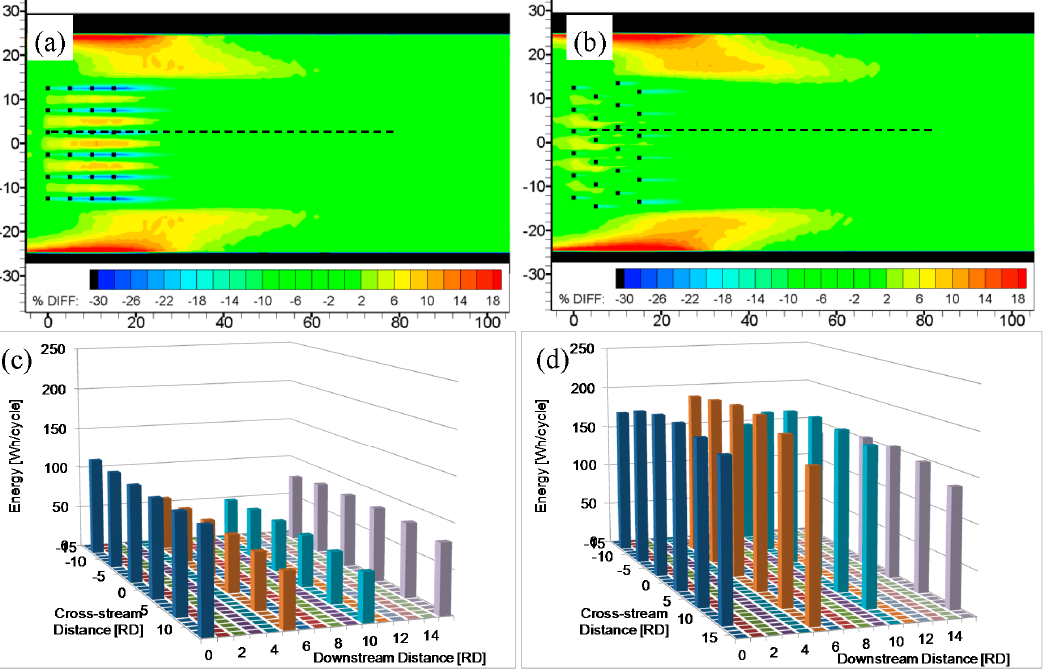
Figure 14. ( a , b ) Changes in current speed and ( c , d ) energy capture for the in ‐ line and staggered arrays, respectively.